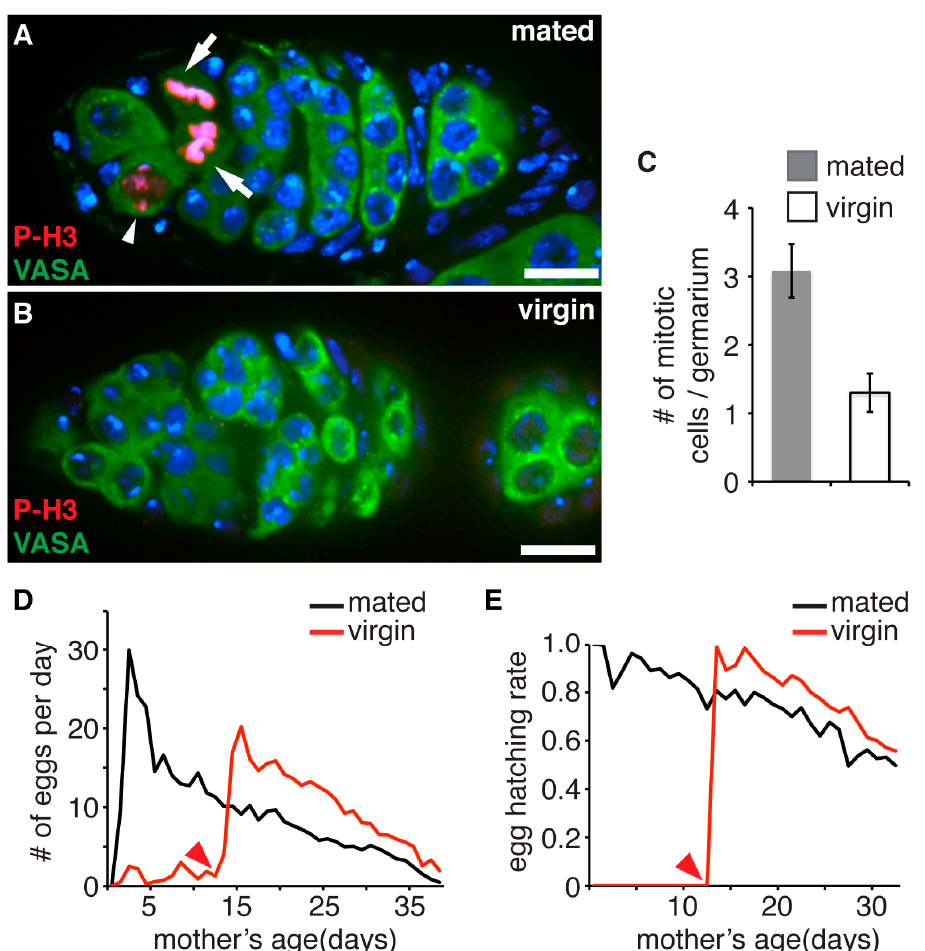
Figure 2. Germline stem cell (GSC) proliferation cycle contributes to the age dependent decline of female fecundity and progeny’s fitness. ( A , B ). Representative images of germarium from 1-week-old mated ( A ) or virgin ( B ) female, stained with anti-VASA (green) for germ line cells and anti- phosphorylated histone H3 (P-H3, red) for mitotic cells. In mated flies, dividing GSC (arrowhead) and germ cell cysts (arrows) are present. Scale bar: 10 µm. ( C ) Quantification of mitotic germ cells in germaria of mated and virgin female flies. No. (#) of mitotic germ cells flies is significantly less in virgin than mated flies ( n = 100 germaria, p < 0.001). We also counted the P-H3 positive GSCs. There were 13 dividing GSCs in total from 100 germaria of mated female flies, but only four out of 100 virgin females. ( D ) Female fecundity was assayed by calculating the average egg production per female per day over 40 days. ( E ) Egg hatching rates plotted over maternal age. Black line, mated female flies; red line, female flies maintained as virgins for two weeks after eclosion. A total of 150 female flies were used for each group in ( D , E ). Each group was assayed in 30 vials with five female flies in each vial. Arrowhead, time point when virgin flies were mated with males.